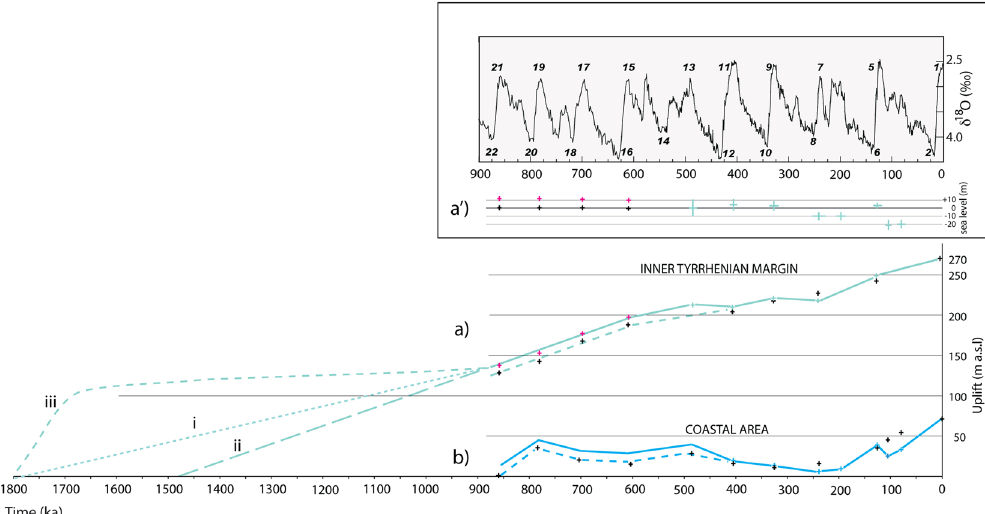
Figure 6. Uplift history. The uplift affecting the investigated area since 900 ka (green solid line) is assessed based on elevation of the terraced surfaces correlated with the MISs (black crosses) corrected for the different sea-level with respect to present day at each interglacial ( a ′ ; green crosses). The coeval uplift assessed on the Tyrrhenian Sea coast is also shown (blue line; ref. 12). Three different uplift histories are hypothesized for the 1.8–0.9 Ma interval, assuming a constant rate since 1.8 Ma to reach the elevation at MIS 21 (i), assuming the same rate as that characterizing the 0.9–0.5 Ma interval (ii), and considering biostratigraphic data from Monte Mario and Monte Riccio (see text) suggesting a sea-level fall of ca. 120 by 1.7 Ma (iii). Isotopes curve in a ′ hand drawn with Adobe© Illustrator CS3 13.0.0 graphic